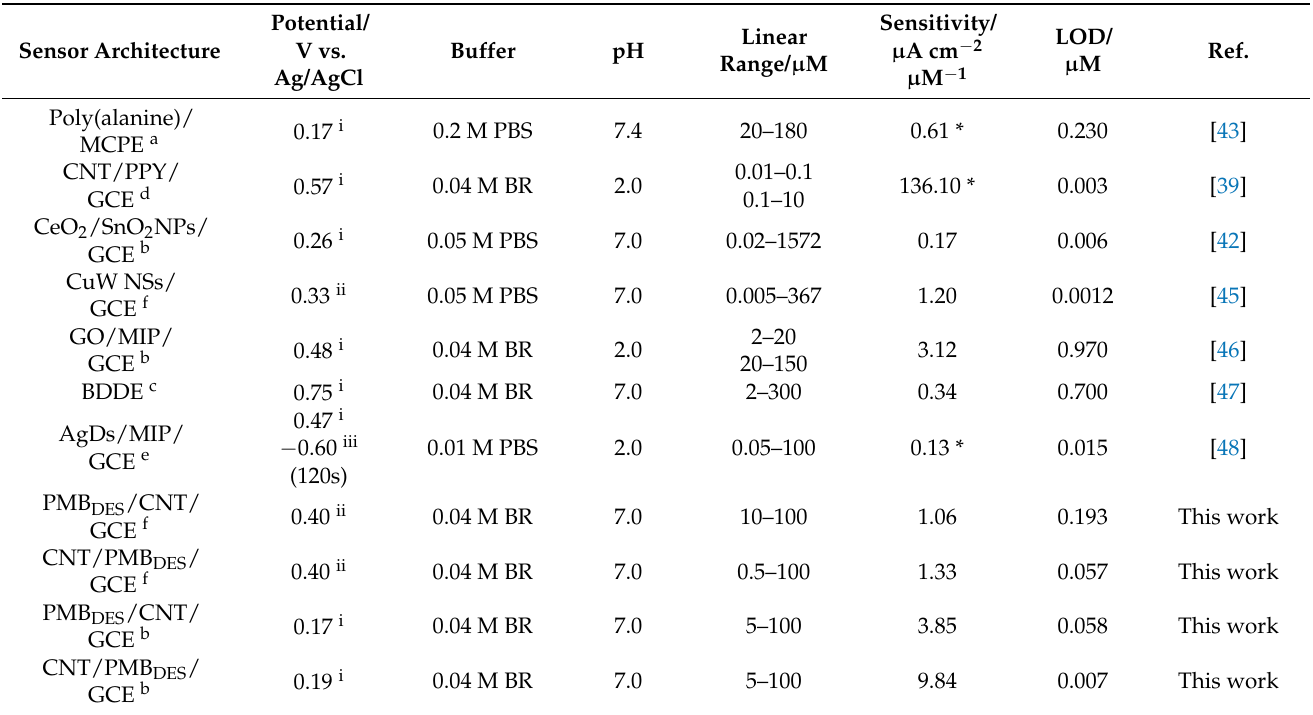
Table 1. Determination of 5-ASA with different modified